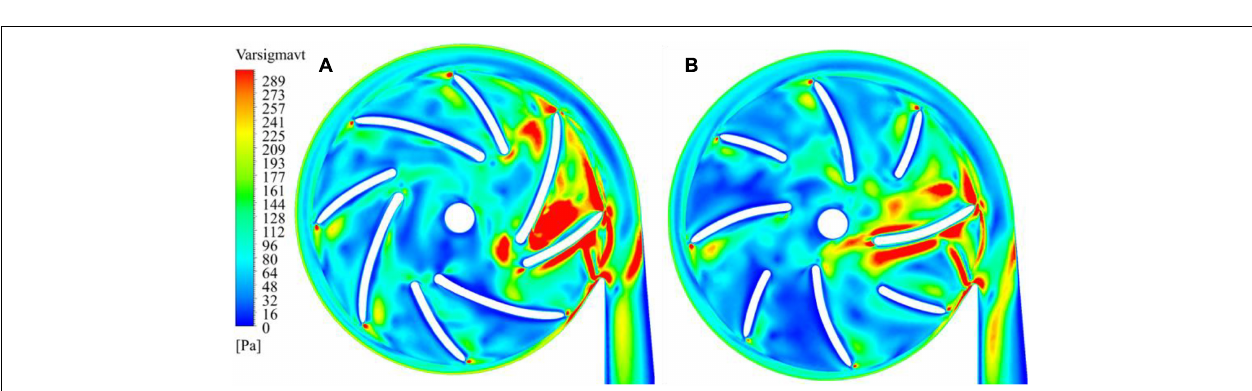
FIGURE 3 | Contours of invariant Q of velocity: (A) model 1 [blade angles of (14 ◦ , 41.7 ◦ )]; (B) model 2 [blade angles of (63.3 ◦ , 62.7 ◦ )]. (C) The plane where the 2D contours in this study were taken from.